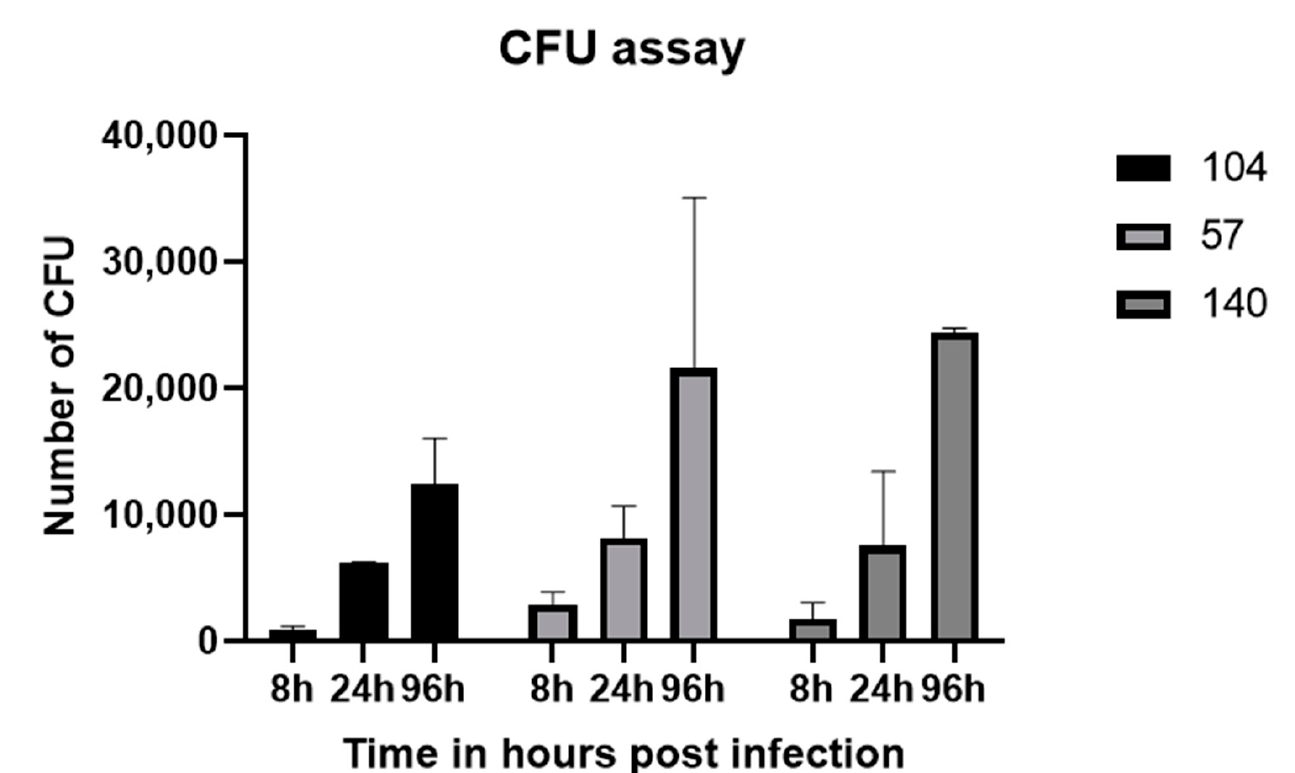
Figure 2. Fungal tissue burden in zebrafish larvae that were infected with yeast cells of C. albicans strains 104, 57, or 140. Each experiment was performed in triplicate. CFU, colony forming unit.